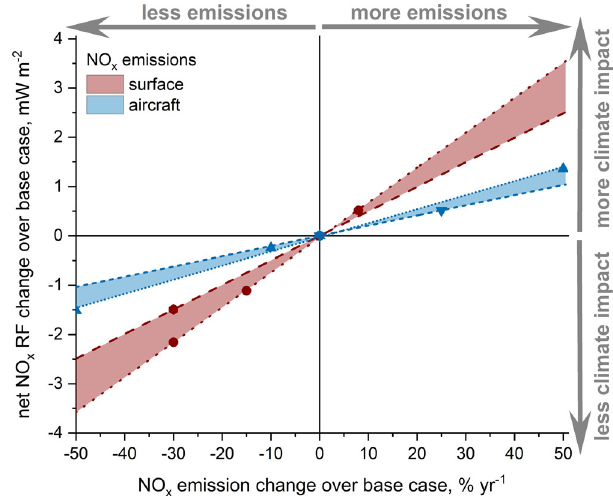
Fig 3 Aviation net NO x radiative forcing change versus percentage change in NO x emission rates from surface and aviation sources. The aviation NO x response has been explored for varying, both, surface (red) and aviation (blue) emissions (dots are individual experiments, lines are the best fi t lines). In the red case whilst surface NO x emissions are changing, aircraft NO x emissions are kept constant and this has been analysed for the highest and lowest projected range of aircraft NO x emissions, 2050 HighNO x -LowTech scenario (red dashed line; n = 2, r 2 = 1.00) and 2006 REACT4C (red dotted line; n = 4, r 2 = 1.00, p < 0.05). In the blue case whilst aircraft NO x emissions are changing, the surface NO x emissions are kept constant and this has been analysed for the highest and lowest projected range of surface NO x emissions, 2005 IPCC AR5 (blue dotted line; n = 4, r 2 = 0.998, p < 0.05) and 2050 RCP 2.6 (blue dashed line; n = 3, r 2 = 0.998, p < 0.05). The exact experiments that are used here are presented in Supplementary Table 1.